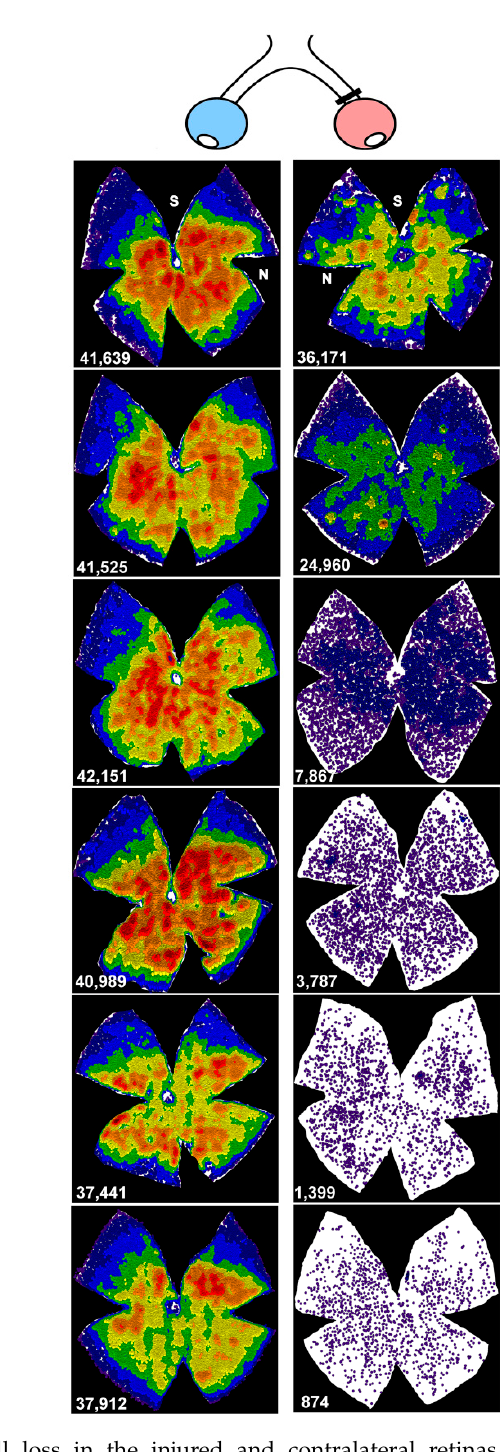
Figure 3. Topography of retinal ganglion cell loss in the injured and contralateral retinas. Top, drawings representing both eyes, their optic nerves, and the lesion site. Left: ONC performed at 2 mm. Right: ONC performed at 0.5 mm. Blue eyes: contralateral. Red: injured. Below: neighbour maps illustrating the topography of surviving RGCs from 3 to 90 days in representative retinas from each group. These neighbour maps illustrate the number of RGCs around a given RGC in a radius of 0.200 mm with a colour scale (top, second from the left panel) from 0–25 neighbours (purple) to >201 neighbours (dark red). The bottom left of each map shows the number of RGCs counted in the original retina. d: days post-lesion; S: superior; N: nasal.